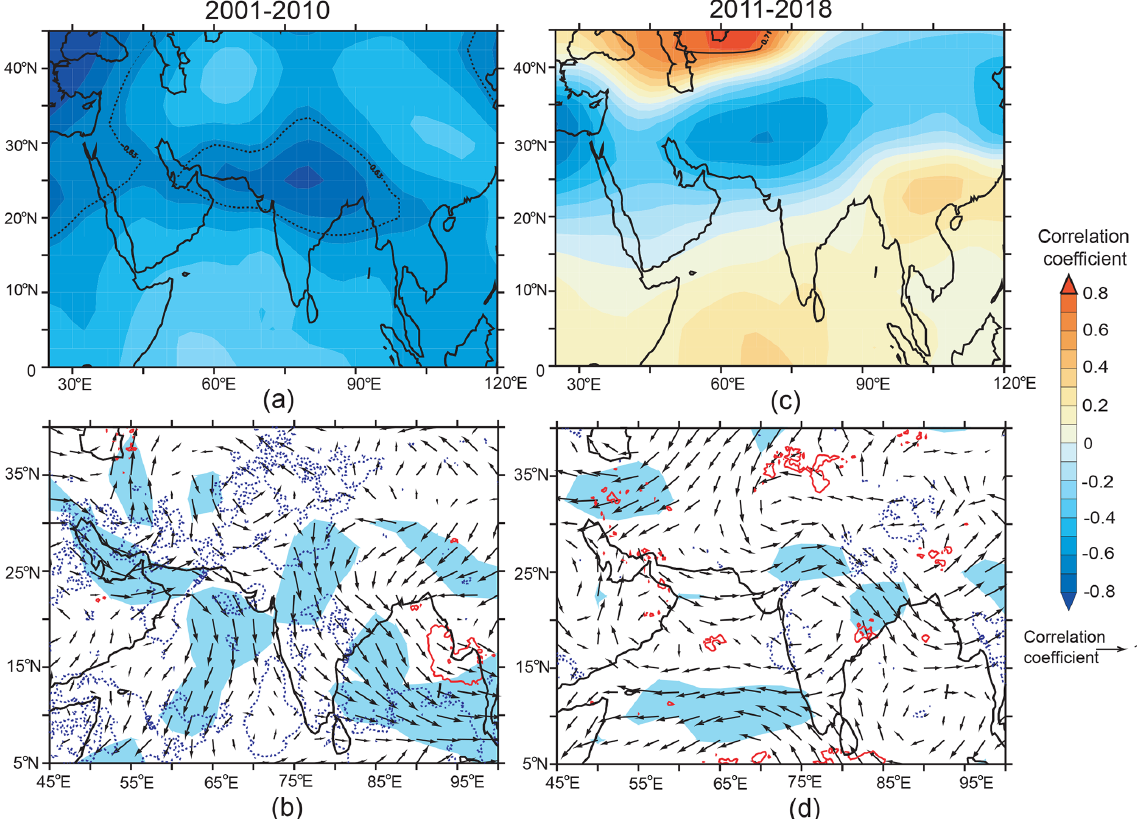
Figure 6. Correlation between the September–October central equatorial Pacific SST and different meteorological parameters averaged for May–September for (a, b) 2001–2010 and for (c, d) 2011–2018. (a, c) Shading shows the correlation between the Pacific SST and geopotential height at the 200hPa pressure level, and the contours enclose the regions where correlations are significant at the 95% confidence level. (b, d) Solid red (dashed blue) contours enclose regions with a positive (negative) correlation between the Pacific SST and precipitation that is significant at the 95% confidence level. Arrows show the correlation between the Pacific SST and wind vectors averaged over 850– 700hPa pressure levels. Light blue shading highlights the regions where one of the components of the wind vector has a significant (at the 95% confidence level)